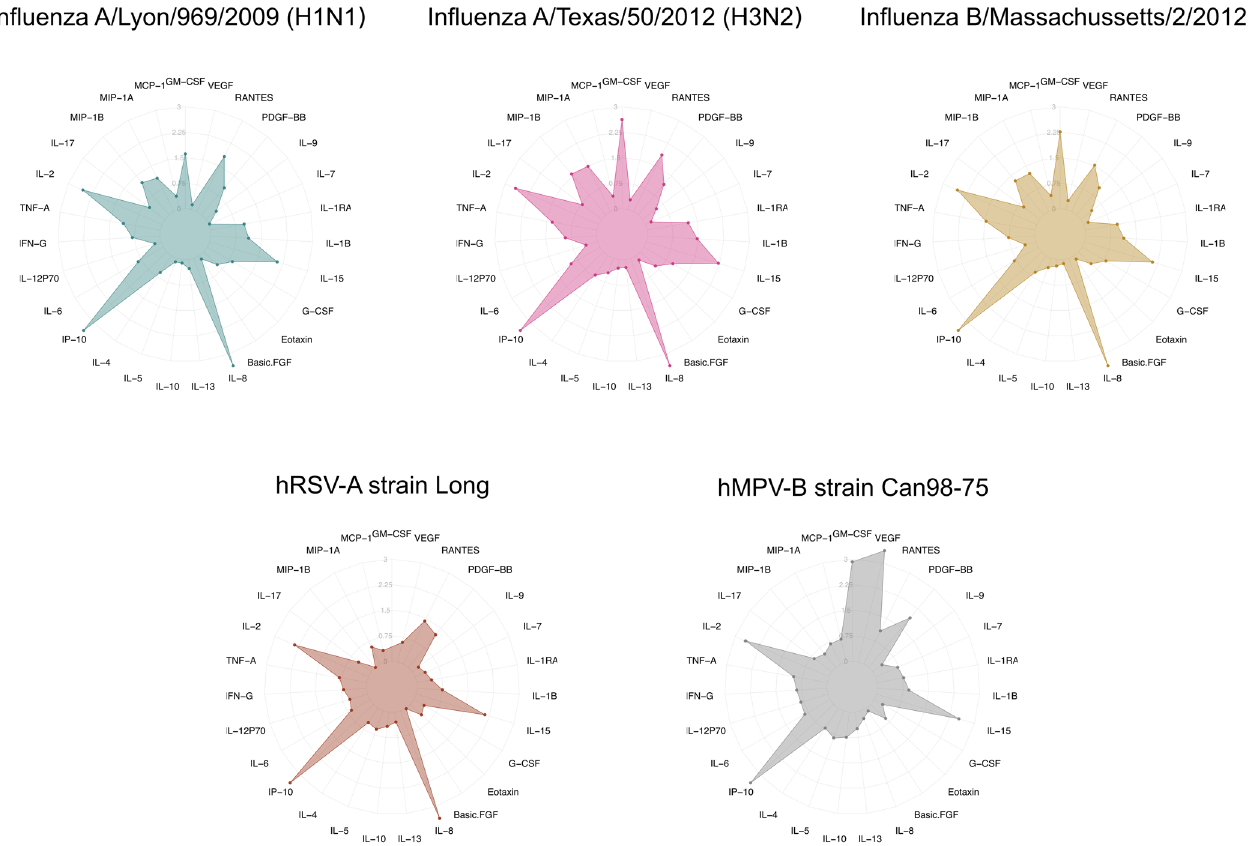
Figure 2. Comparison of immunity-related protein secretion profiles of infected airway epithelia. Chemokines and cytokines (FGF basic, Eotaxin, G-CSF, GM-CSF, IFN- γ , IL-1 β , IL-8, IL-9, IL-10, IL-12, IL-13, IL-15, IL-17A, IP-10, MCP-1, MIP-1 α , MIP-1 β , PDGF-BB, RANTES, TNF- α and VEGF) harvested at the apical pole were quantified on a FLEXMAP 3D analyzer (Luminex, Austin, Texas, USA). Cytokine concentration values are represented in log10-transformation of the ratio (viral cytokine concentration) / (mock cytokine concentration). Because no signal could be assessed for GM-CSF, in the case for hRSV, this specific point was set at 0. Each radar chart accounts for the 27 cytokine/chemokine levels in each viral